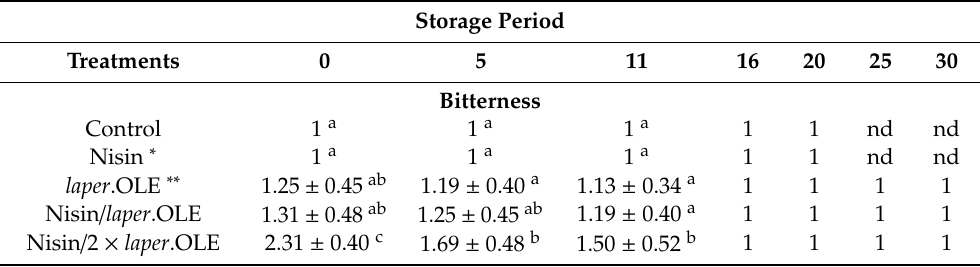
Table 3. Sensory scores (bitterness) of treated and untreated camel steaks packed under modified atmosphere (MA) during period of refrigerated